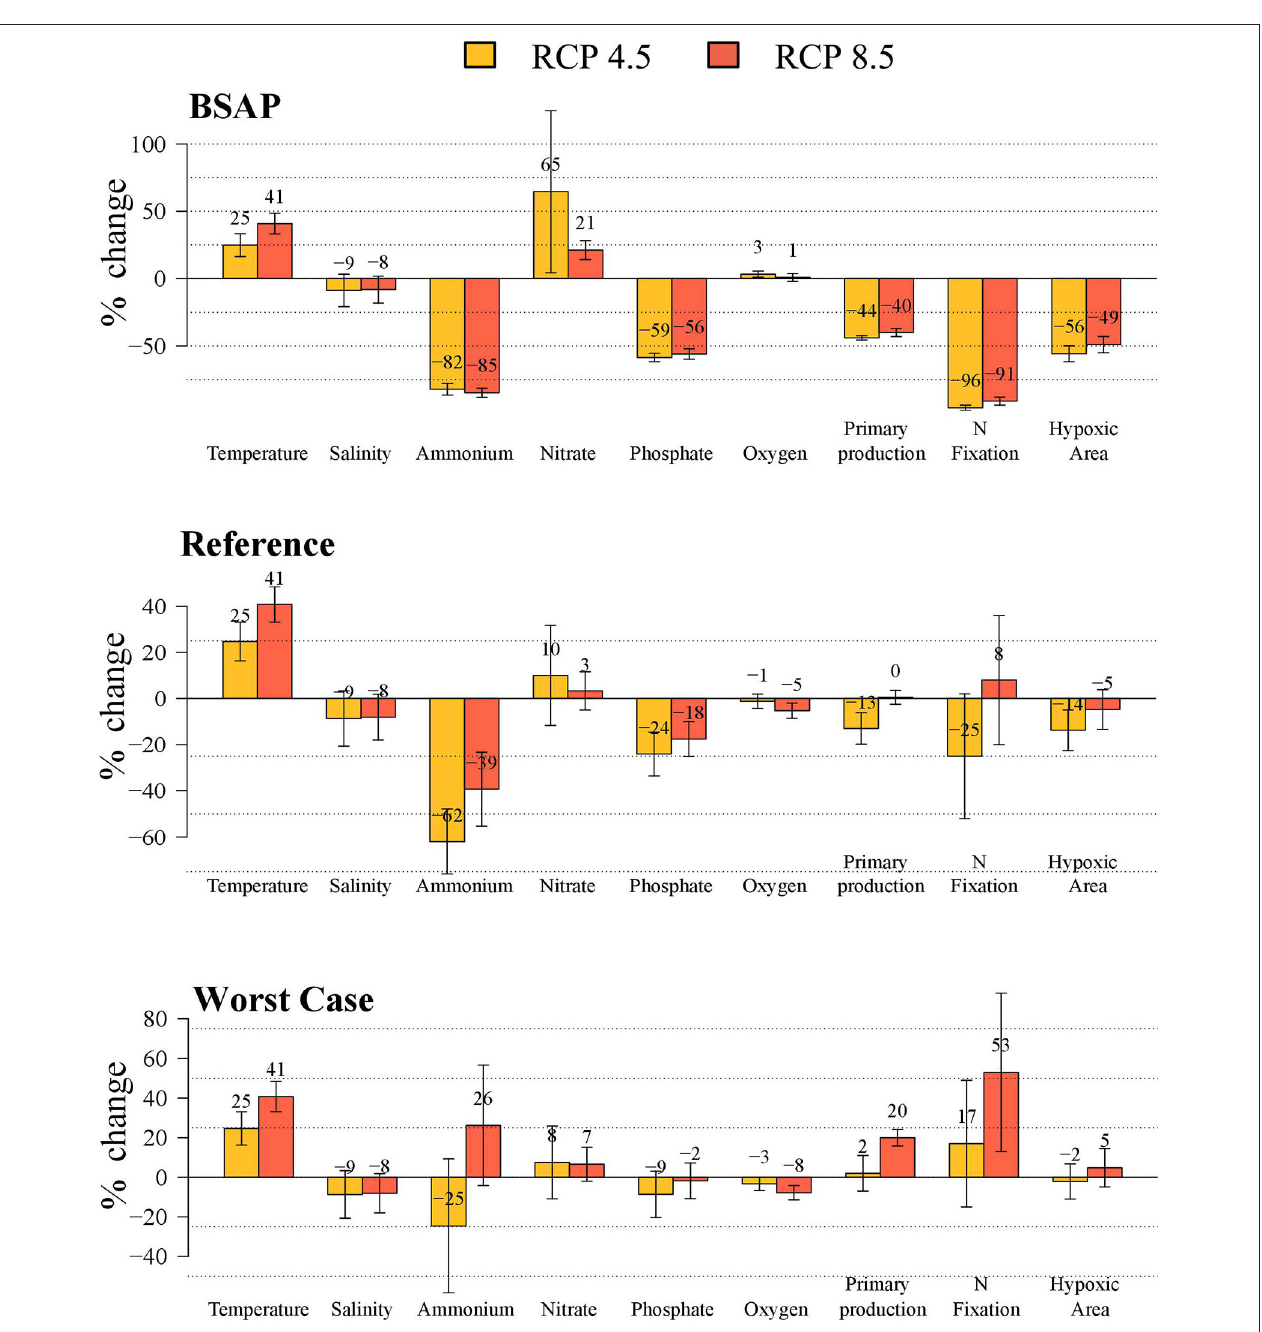
FIGURE 7 | Relative ensemble mean volume averaged, 30 years mean changes between the future (2069–2098) and historical (1976–2005) periods in temperature, salinity, nutrient and oxygen concentrations, primary production, nitrogen fixation and hypoxic areas in the entire Baltic Sea under the different climate and nutrient load scenarios: BSAP (upper panel), Reference (middle panel) and Worst Case (bottom panel). The relative temperature changes are based on temperatures in ◦ C . In addition, the standard deviations of changes among the ensemble members are shown.